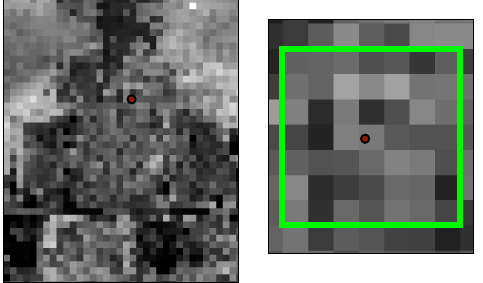
Figure 4 . CHM pixels for a site within secondary forest, with corresponding image tensor